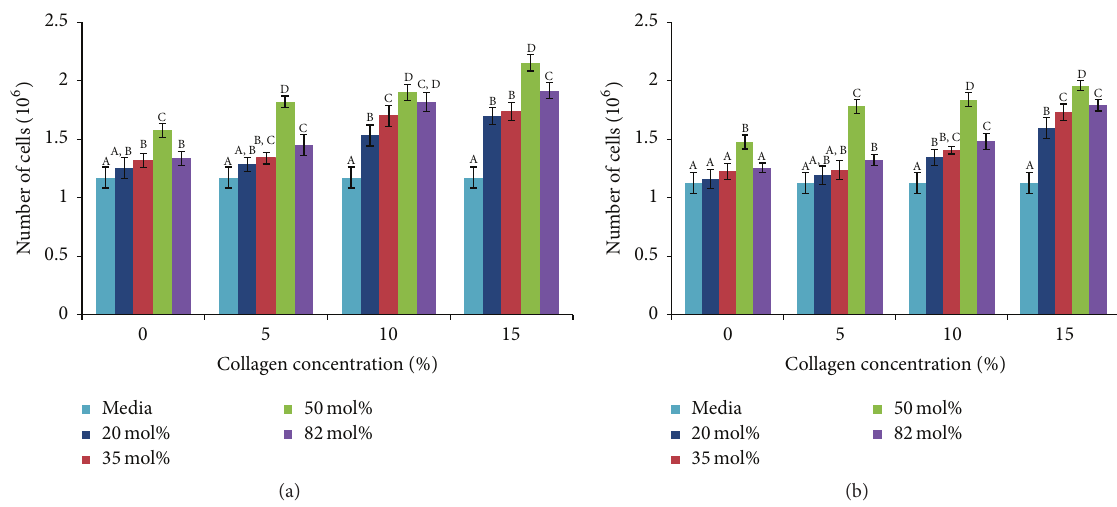
Figure 4: (a) Proliferation of L929 cells on day 3 seeded on the various P(3HB- co -4HB)/collagen blend scaffold of varying collagen concentration with 0.1 mm thickness. Values are mean of four replicates. Mean data accompanied by different alphabets indicates significant difference within the group (Tukey’s HSD test, 𝑝 < 0.05 ). (b) Proliferation of L929 cells on day 3 seeded on the various P(3HB- co - 4HB)/collagen blend scaffold of varying collagen concentration with 0.2 mm thickness. Values are mean of four replicates. Mean data